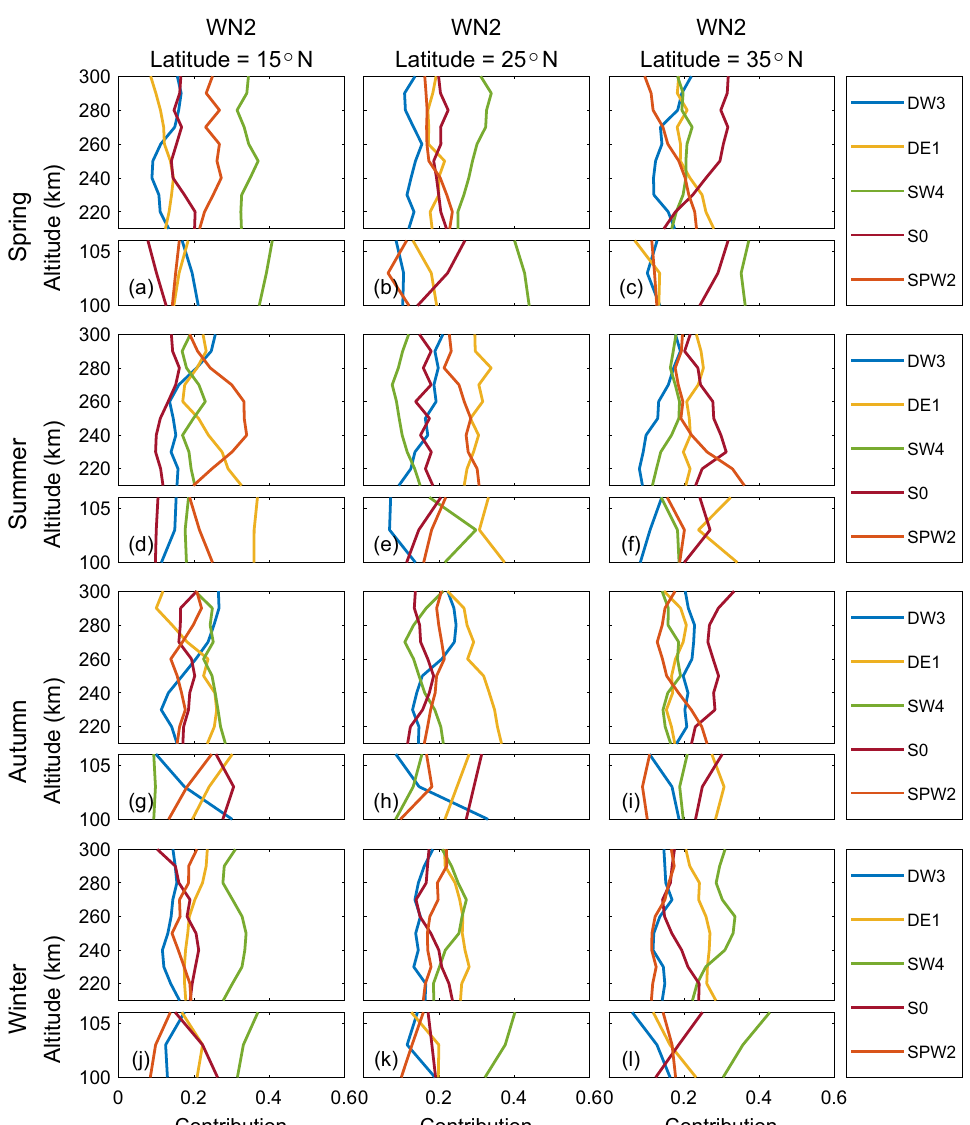
Fig. 5 Same as Fig. 4, but shows the contribution of potential sources to WN2, the blue, yellow, green, purple and orange line represent DW3, DE1, SW4, S0 and SPW2,